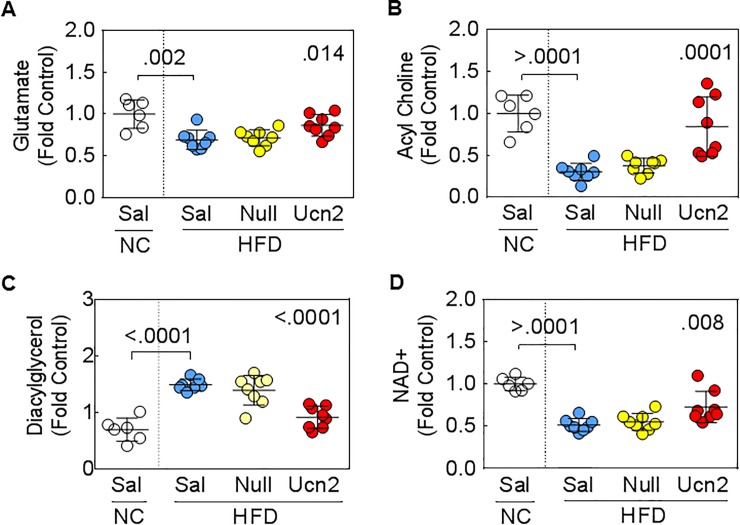
Examples of metabolites restored by Ucn2 expression in mice fed with HFD.A. Glutamate was reduced by HFD and restored close to normal by Ucn2. B. Choline was reduced by HFD and increased close to normal by Ucn2. C. Diacylglycerol was increased by HFD but reduced by Ucn2. D. Nicotinamide adenine dinucleotide (NAD+) was reduced by HFD but increased by Ucn2 expression. SID: ScaledImpData, where each biochemical in original scale is rescaled to set the median equal to 1. Sal, saline; Empt, AAV8.Empt; Ucn2, AAV8.Ucn2. Data are mean+SEM; p values on left side in the graph were from Student’s t-test and on the right were from one-way ANOVA. Group size: CHOW-saline, n = 6; HFD, n = 8 per group.